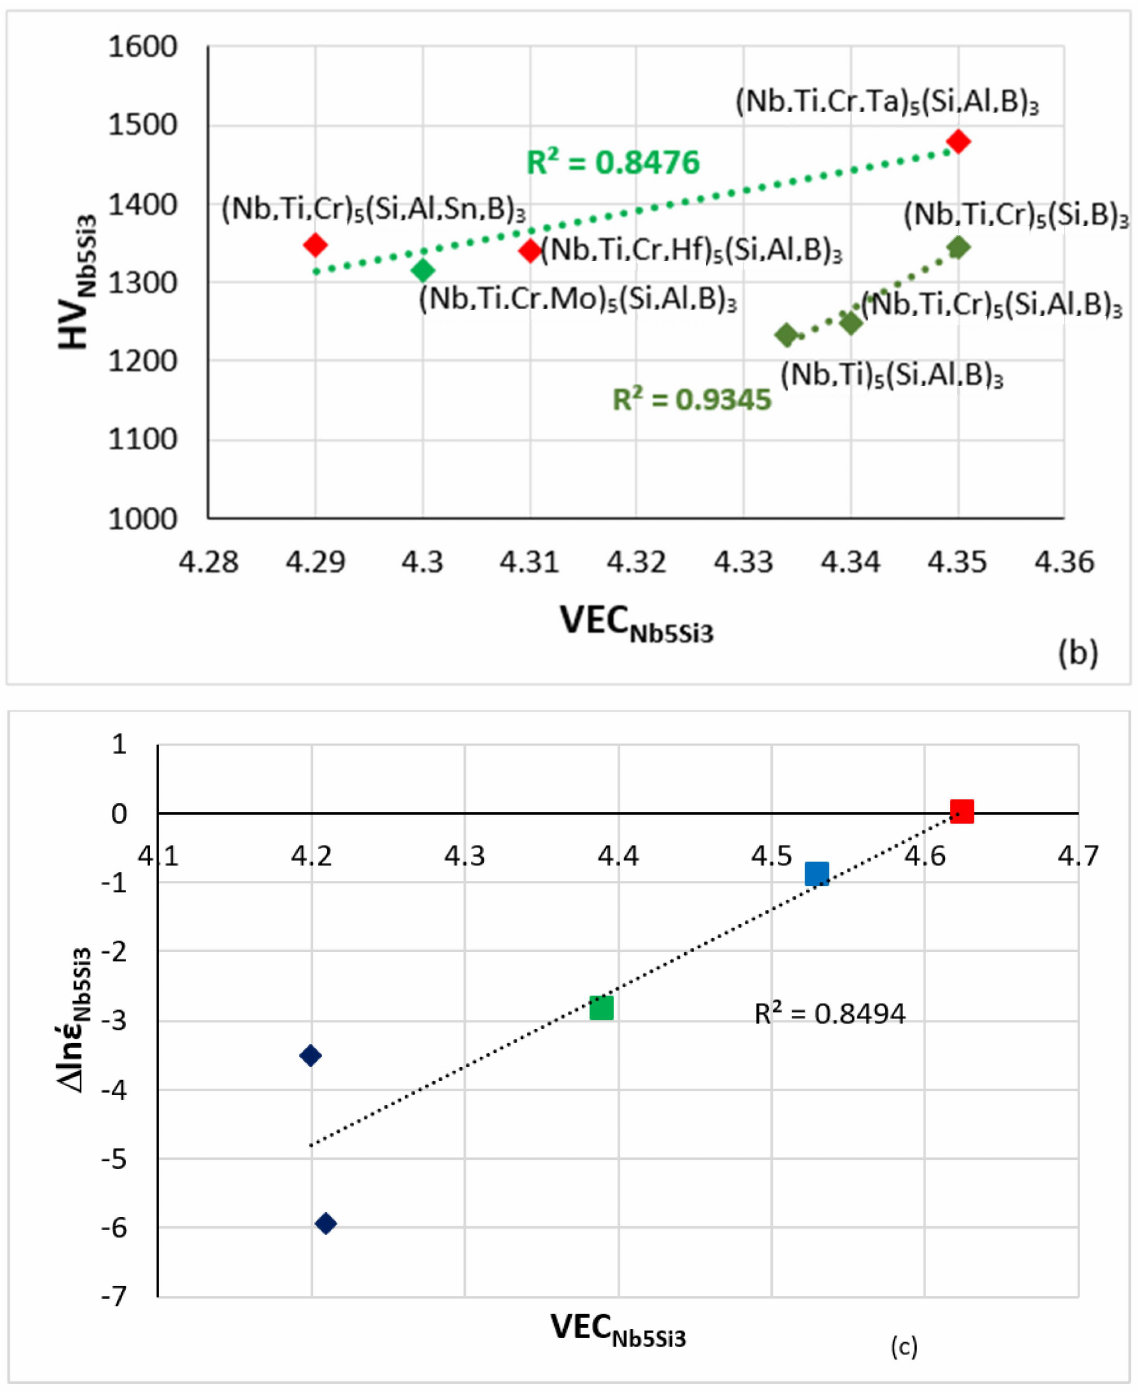
Figure 5. ( a , b ) Vickers hardness of alloyed Nb 5 Si 3 versus VEC. ( a ) Silicide in boron-free RM(Nb)ICs, triangles and square in RM(Nb)ICs with Ge or Sn addition, respectively ( b ) Silicide in boron con- taining RM(Nb)ICs (diamonds), of which those that also are RM(Nb)ICs/RCCAs are shown in red. ( c ) Change of creep rate ( ∆ ln´ ε ) versus VEC at 1200 ◦ C and 150 MPa with reference the bi- nary Nb 5 Si 3 , data from [1,9]. Colours in ( c ): tetragonal unalloyed Nb 5 Si 3 (red square), tetragonal (Nb,Ti) 5 Si 3 (blue square), tetragonal (Nb,Ti,Cr,Hf) 5 (Si,Al,B) 3 (green square) and hexagonal (Nb,Ti) 5 Si 3 and (Nb,Ti,Hf) 5 Si 3 (blue diamonds). The more negative ∆ ln´ ε is, the higher is the creep rate compared with α Nb 5 Si 3 at the said